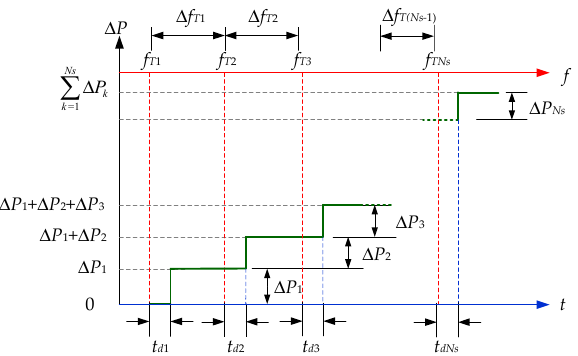
Figure 3. Power–frequency–time ( P – f – t ) schematic representation of the settings of an under-frequency relay (UFR).